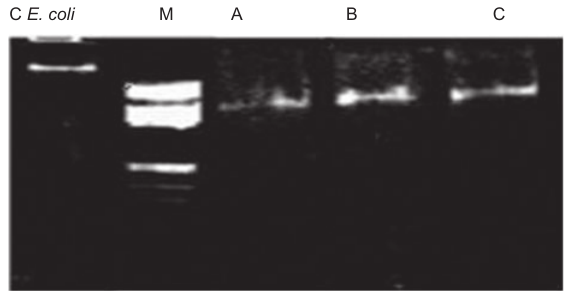
Table 4 . Synthesis of AcBDZH is shown in Scheme 2 .